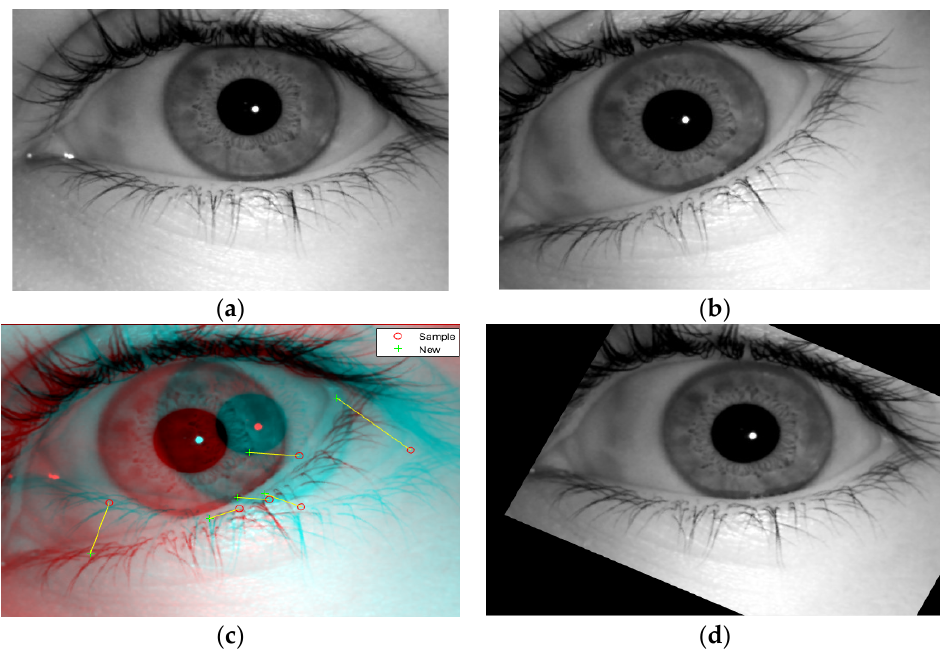
Figure 3. Image Registration. ( a ) Sample Image. ( b ) New Image. ( c ) Matching Points Between both images. ( d ) Rotated/Registered Image.